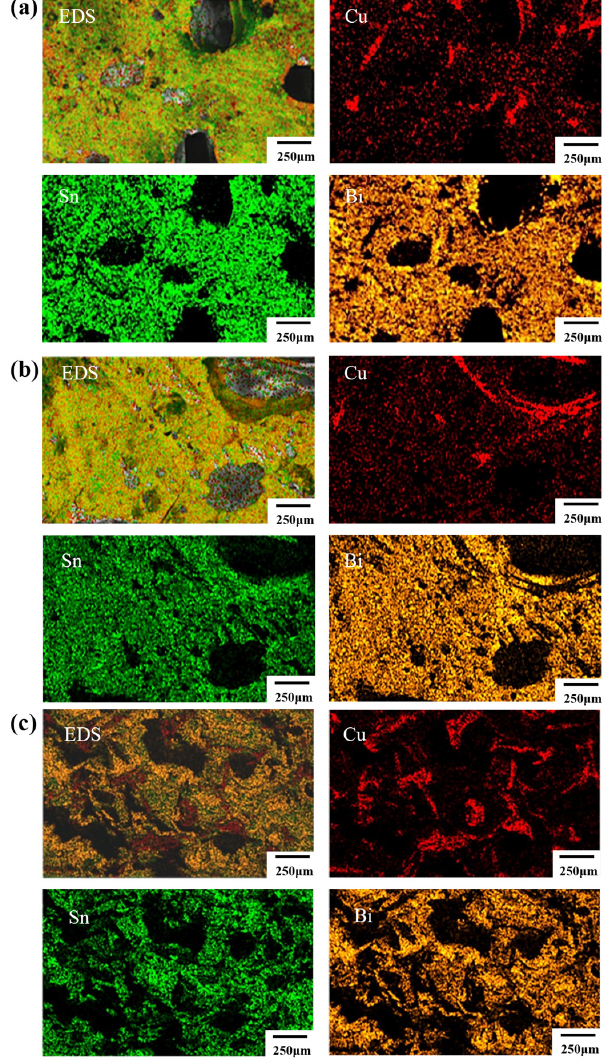
Figure 8. The EDS mapping results of the fractured joints obtained under different pressures after shear failure test: ( a ) EDS picture under 3 MPa pressure; ( b ) EDS picture under 5 MPa pressure; ( c ) EDS picture under 20 MPa pressure.